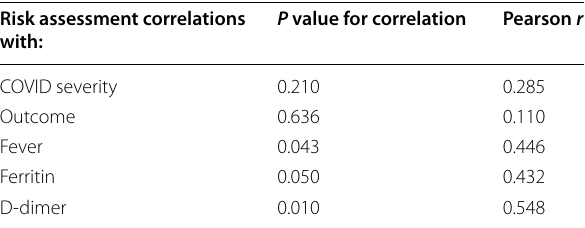
Table 4 Correlation between risk stratification of PH in the last scheduled visit and COVID severity, outcome, fever, serum ferritin, and D dimer